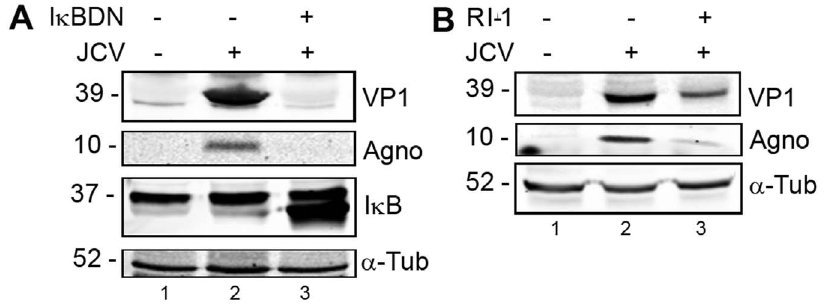
Figure 7. Effect of ectopic expression of I k BDN and RI-1 on JCV infection . A. SVGA cells (SV40 T-Ag-transformed human fetal glial cells) were transfected/infected with JCV with and without expression plasmid for I k BDN as indicated and harvested after 7 d for Western blot. B. SVGA cells were transfected/infected with JCV with and without 15 m M RI-1 Rad51 inhibitor and harvested after 7d for Western blot.